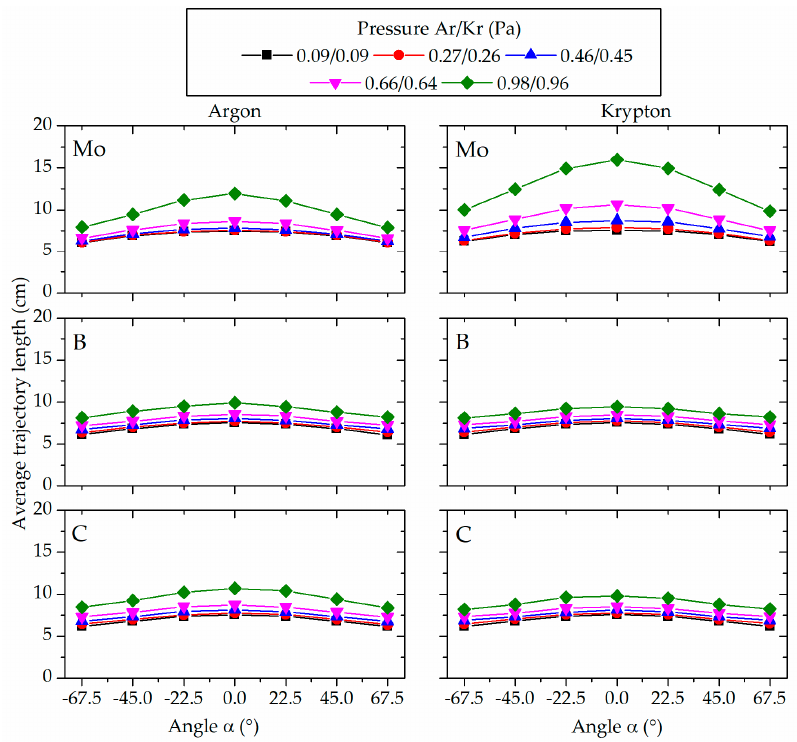
Figure 8. Simulated average trajectory length of the sputtered atoms transported through the gas phase at given Ar ( left ) and Krypton ( right ) pressures. The first pressure value pertains to the Ar depositions, the second value to the Kr depositions.